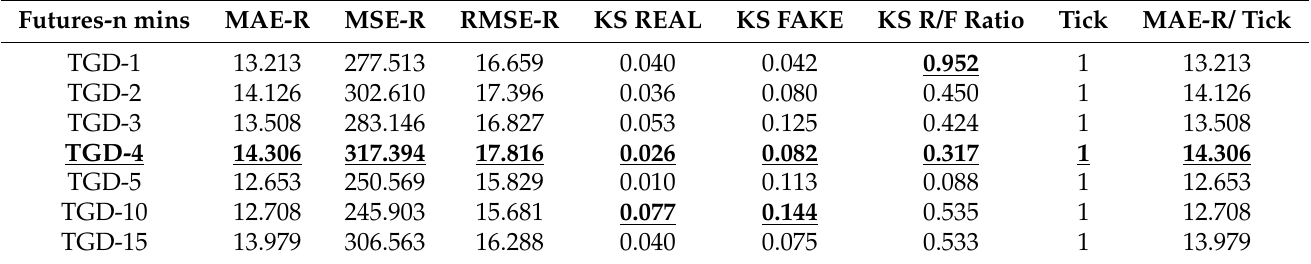
Table 5. TGD-n mins (TOCOM gold) represent futures contracts listed in JPX at one, two, three, four, five, ten and fifteen minutes intervals. For KS R/F Ratio, all are smaller than one, where the highest KS REAL and FAKE are 0.077 and 0.144. Precious futures contract tick value is all one dollar.